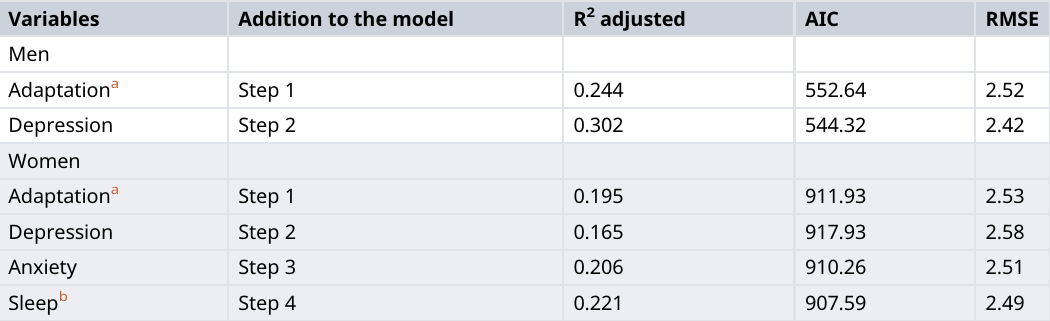
Table 3. Stepwise regression models of the study variables.